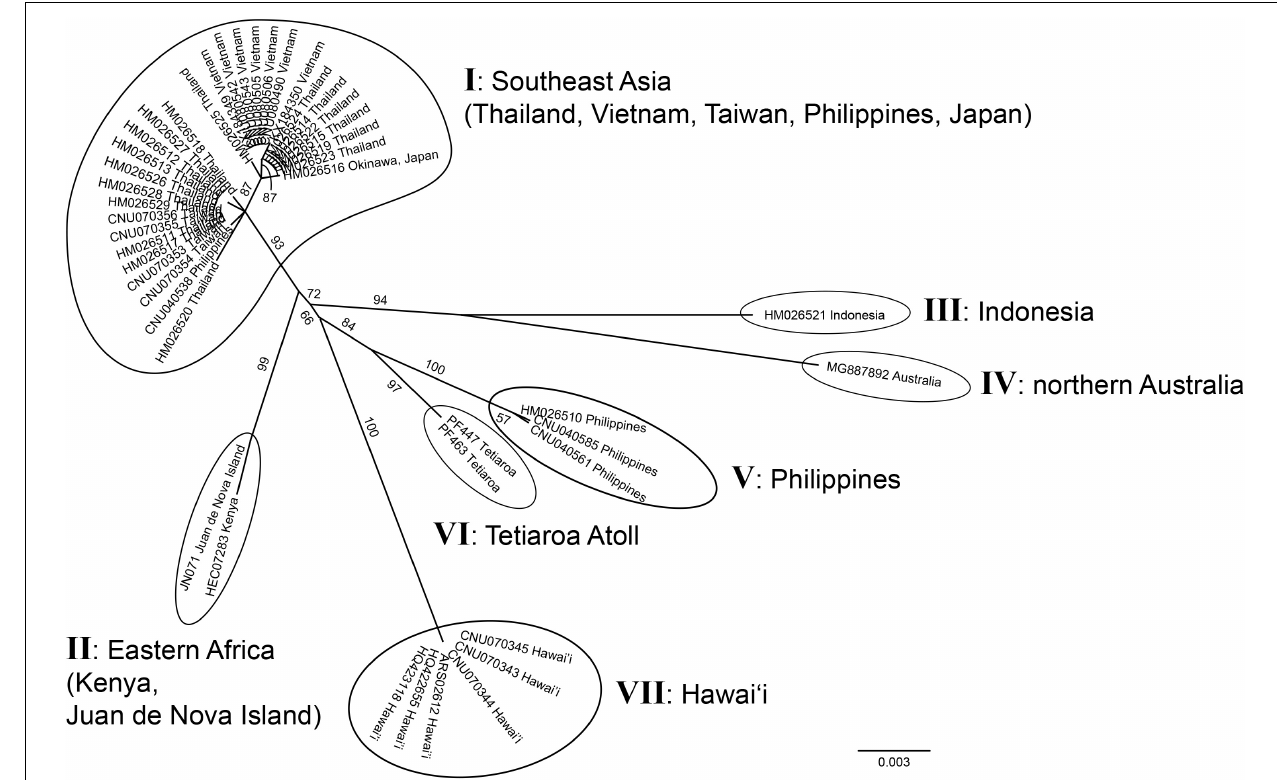
FIGURE 3 | Unrooted phylogeny of Gelidiella fanii obtained by maximum-likelihood inference of mitochondrial cox 1 sequences. ML bootstrap values ( ≥ 50%) are indicated near branches. Seven genetic groups are marked from I to VII.